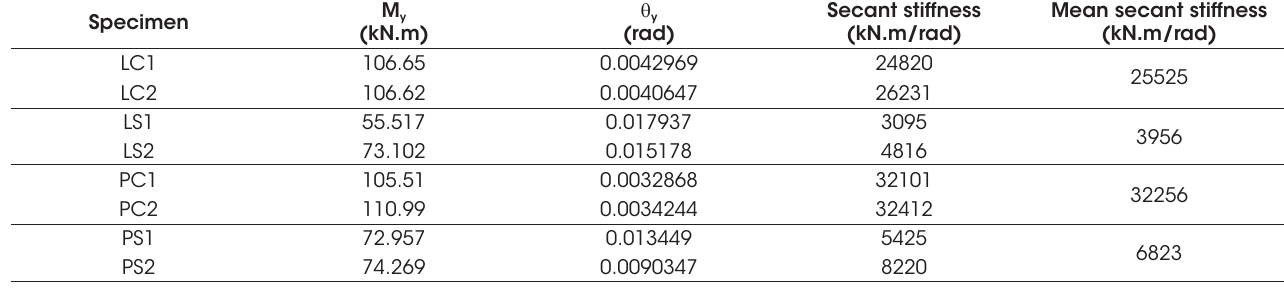
Reaction structure